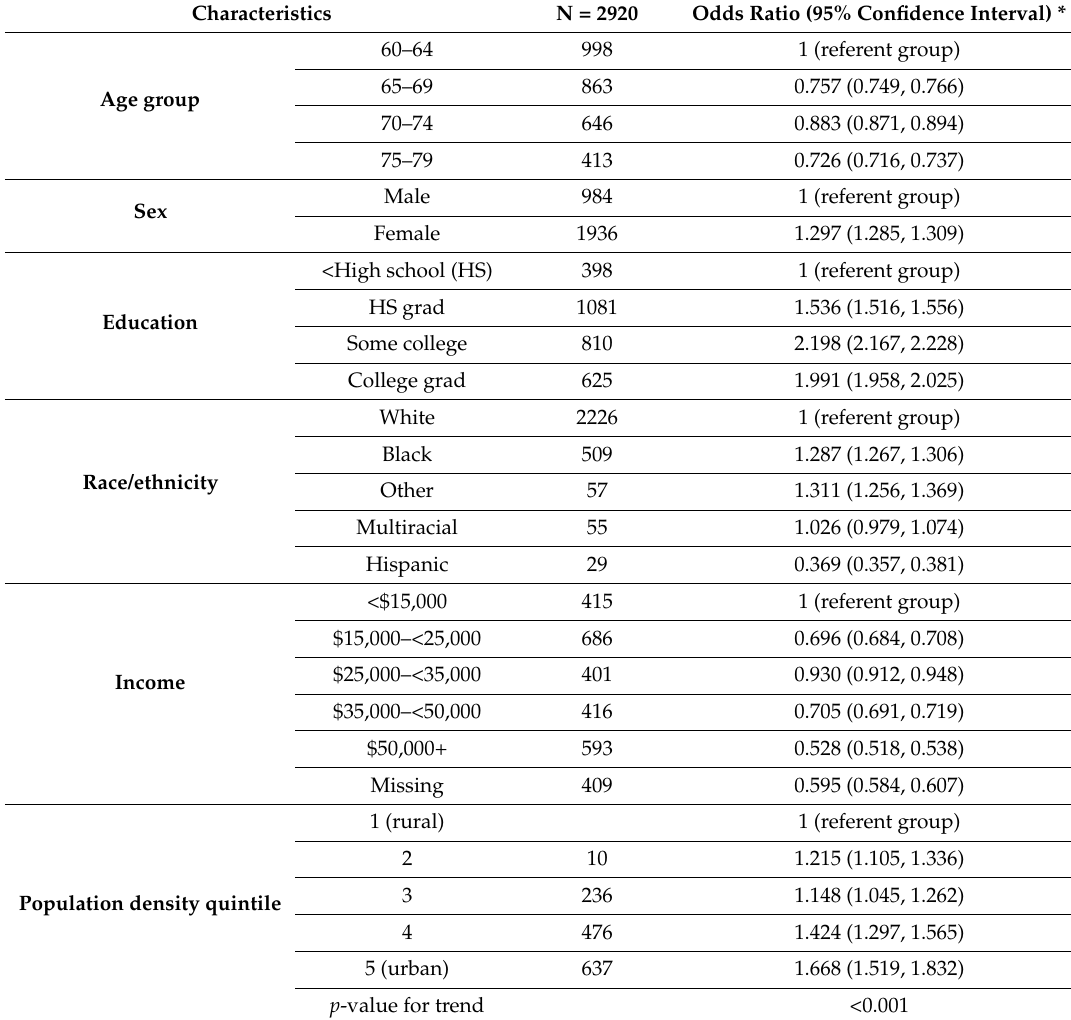
Table 2. Adjusted and weighted odds ratios of receipt of weight loss recommendation (WLR) among adults with arthritis and obesity, Behavioral Risk Factor Surveillance System,